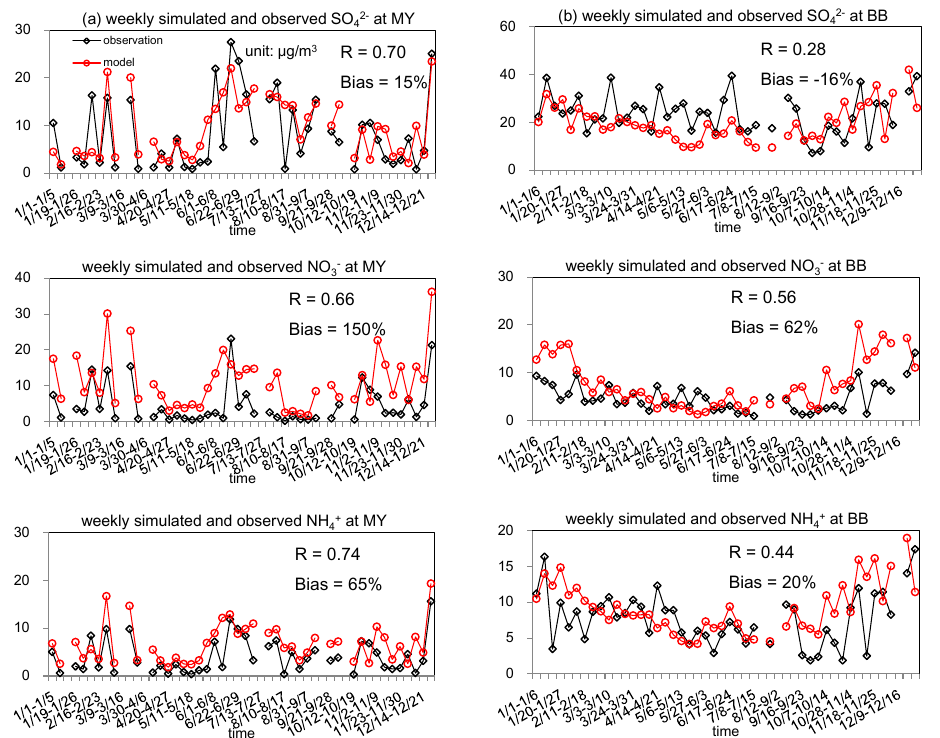
Fig. 6. The weekly averages of simulated and observed mass concentrations of sulfate, nitrate and ammonium (top to down) at the MY (a) and BB (b) sites. The black lines represent observations and the red lines represent the simulation. The correlation coefficient and model bias are given.